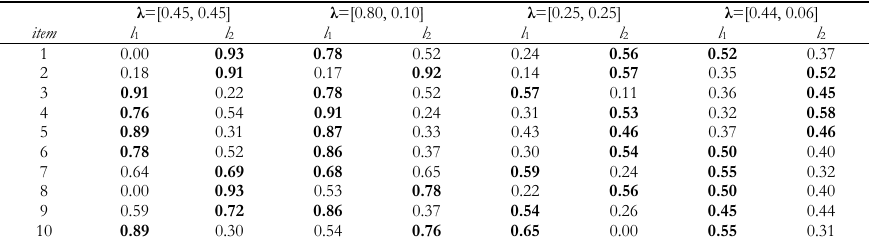
Loadings ( absolute value ) of the m items on the first ( l 1 ) and on the second ( l 2 ) dimensions of the solution of the two-dimensional factor analysis performed on the “non-block” data sets generated with different vaues of λ λ =[0.45, 0.45] λ =[0.80, 0.10]